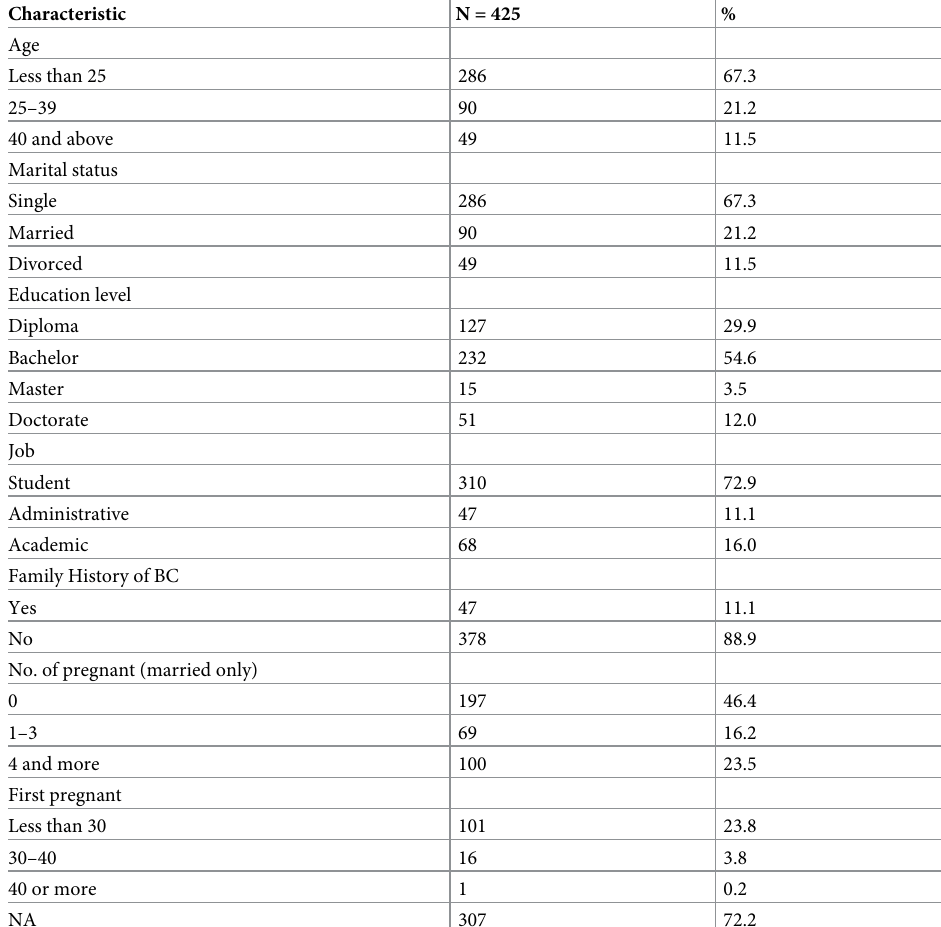
Table 1. Socio-demographic characteristics of the respondents.